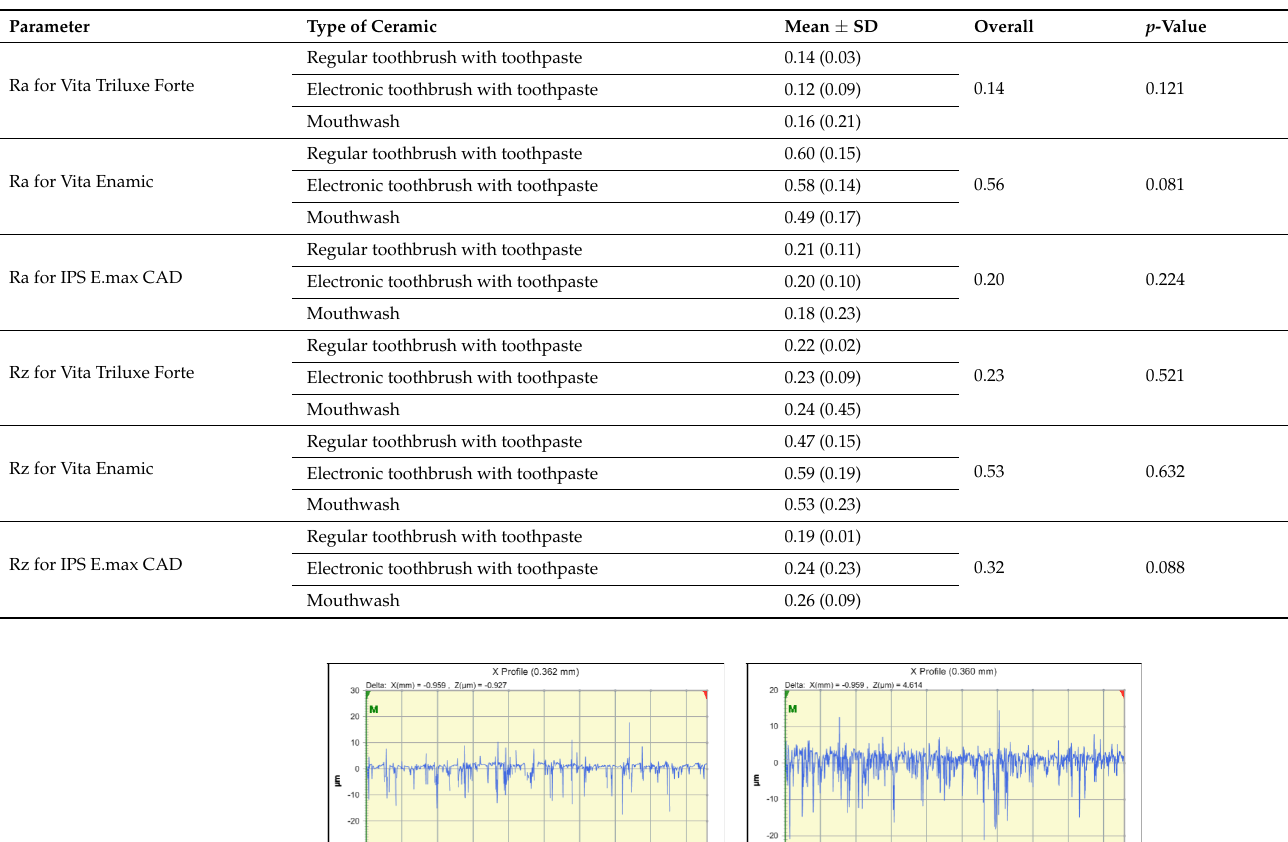
Table 2. Comparison of Ra and Rz amongst different ceramic